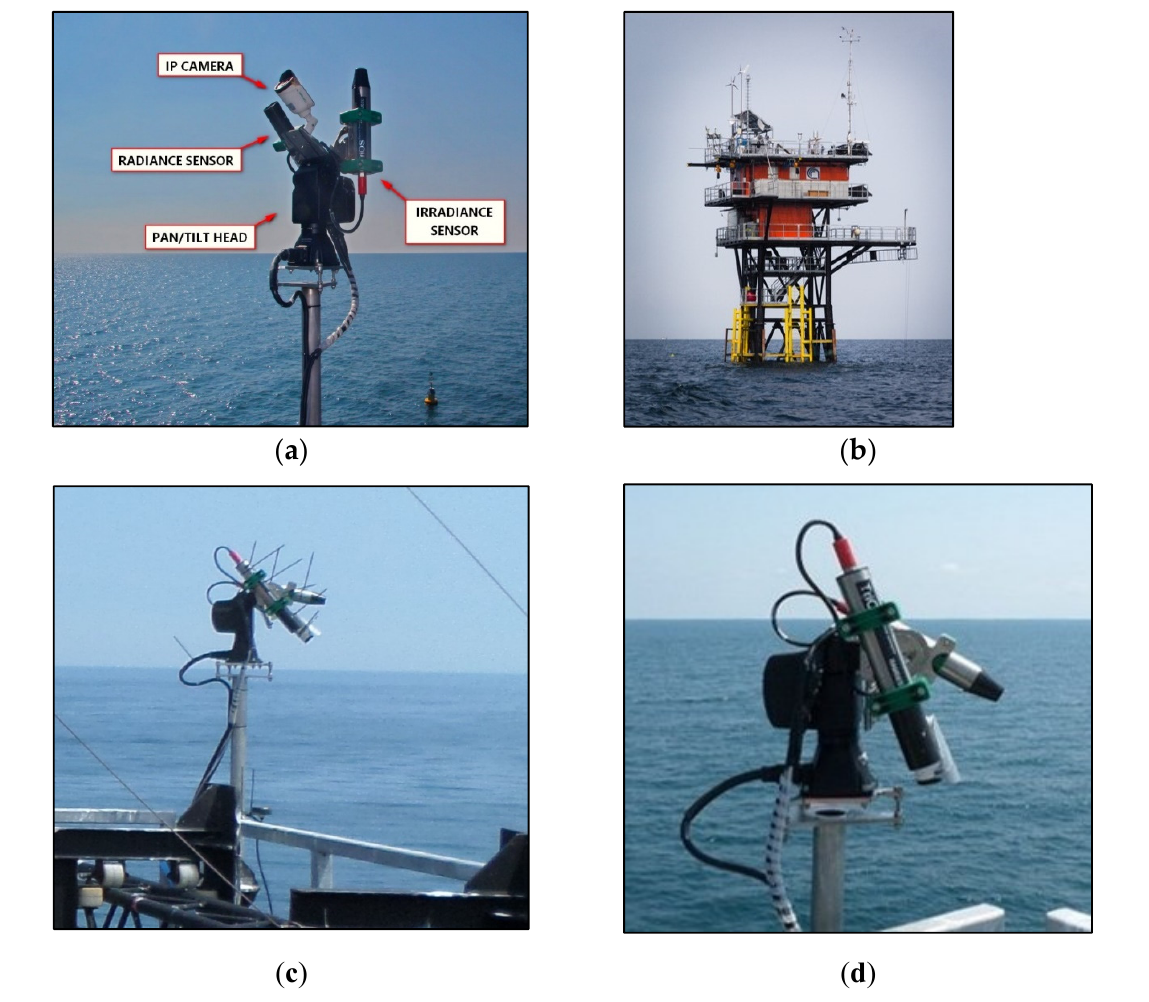
Figure 4. Photographs of PANTHYR prototype deployment at Acqua Alta Oceanographic Tower (AAOT). ( a ) Irradiance and sky radiance measurement position; ( b ) southwest face of the Acqua Alta Oceanographic Tower; ( c ) upwelling (water + skyglint) radiance measurement position; ( d ) park position.